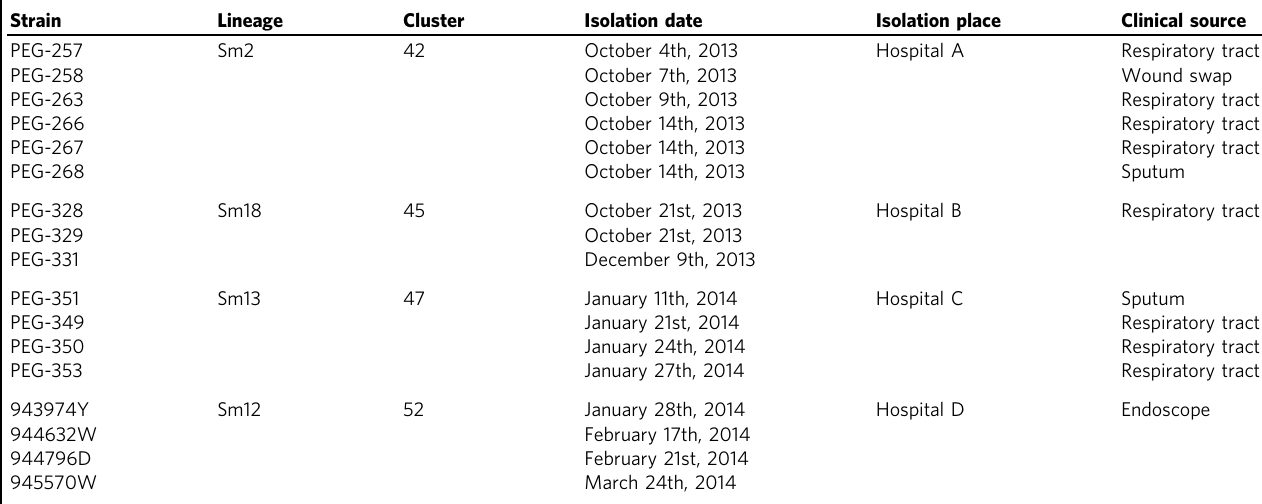
Table 1 Site and date of isolation for the strains comprising the four d10 clusters isolated from the same geographic location within at most an 8-week time